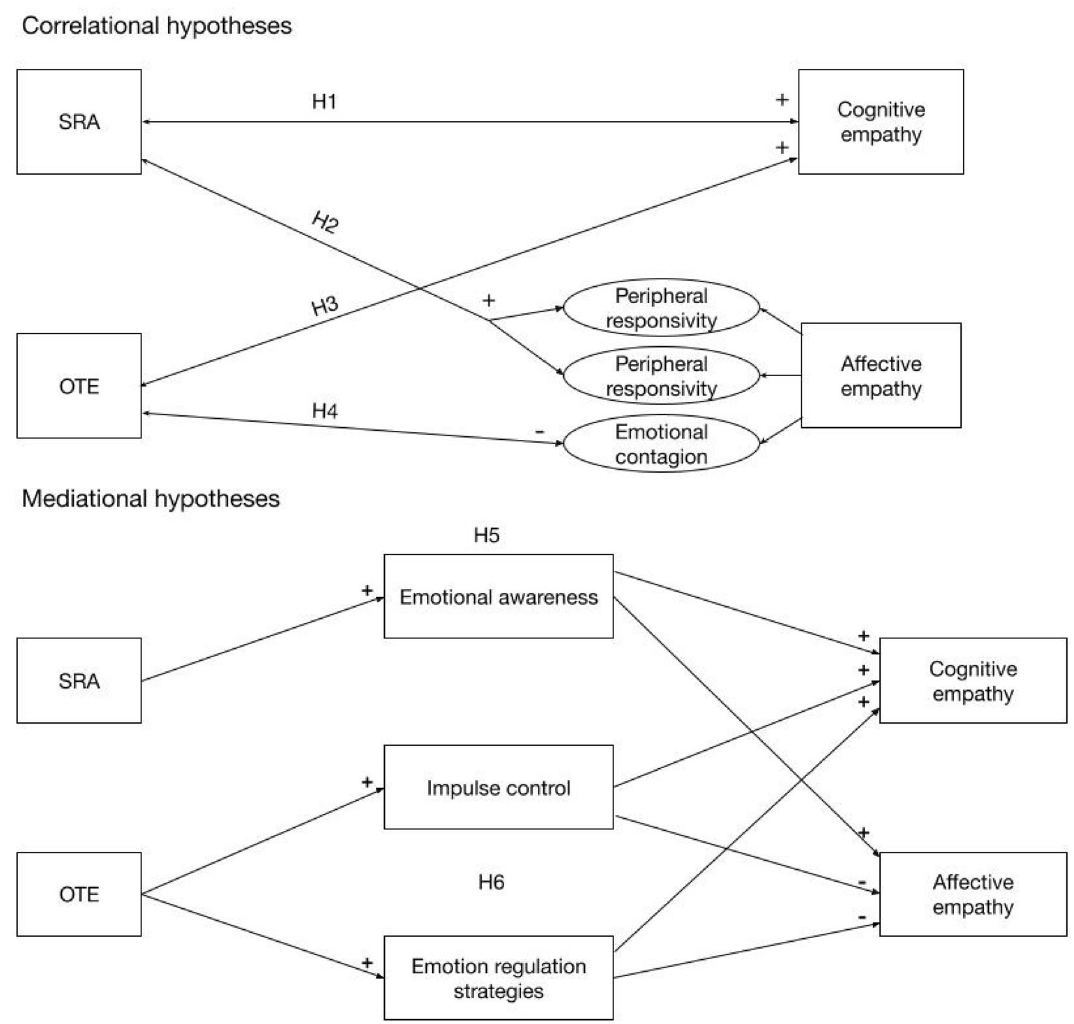
Figure 1. Overview of the a-priori hypotheses. SRA = Self-regulated Attention, OTE = Orientation to Experience. Meditation experience and participants’ sex were controlled as background